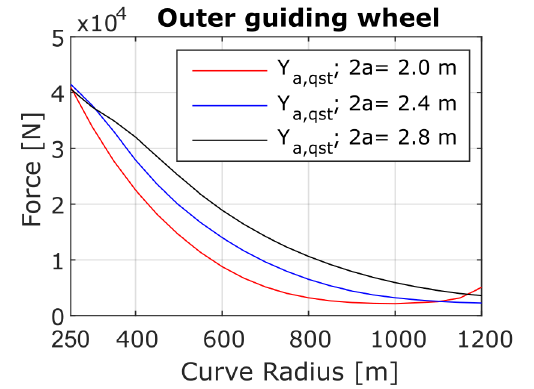
a,qst on the curve